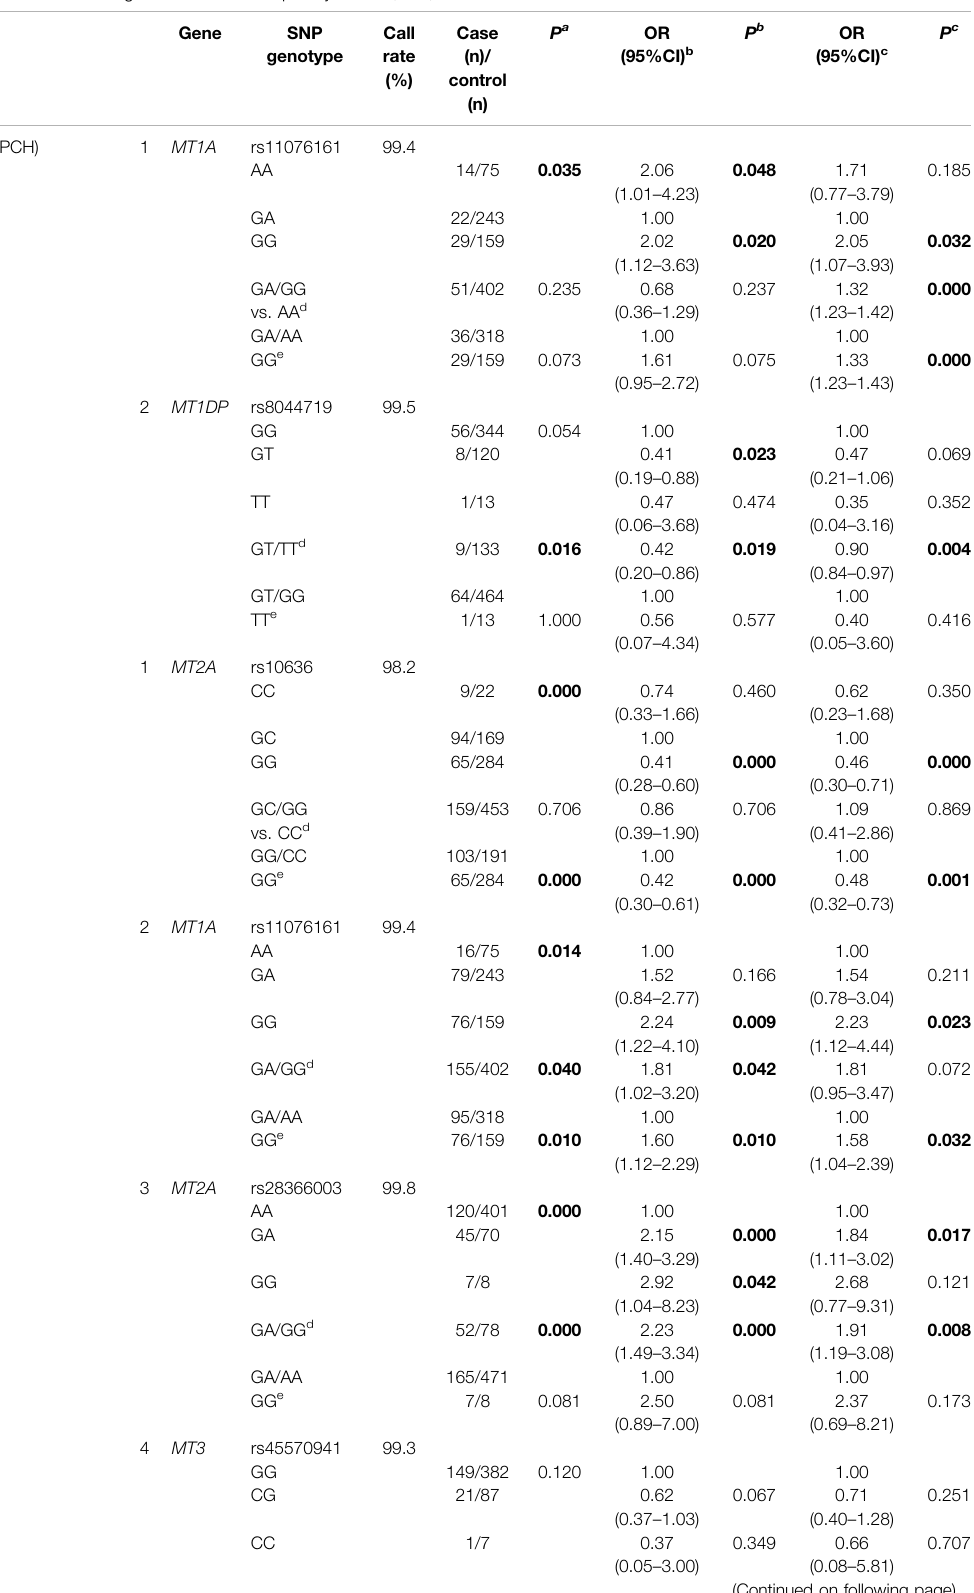
TABLE 2 | Association between assayed SNPs in MT genes and the susceptibility of PCH, GH, and PE/PESCH. Group